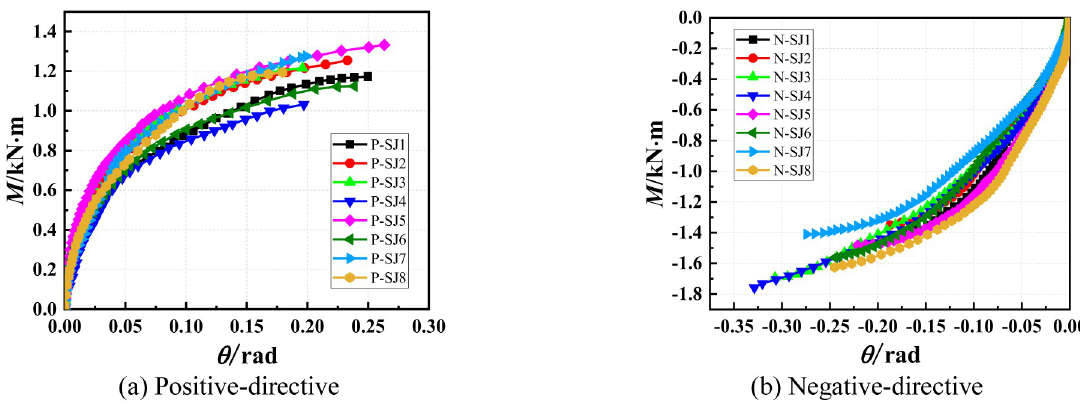
Fig 8. Moment–rotation curves obtained by experiments. (a) Positive-directive. (b) Negative-directive.